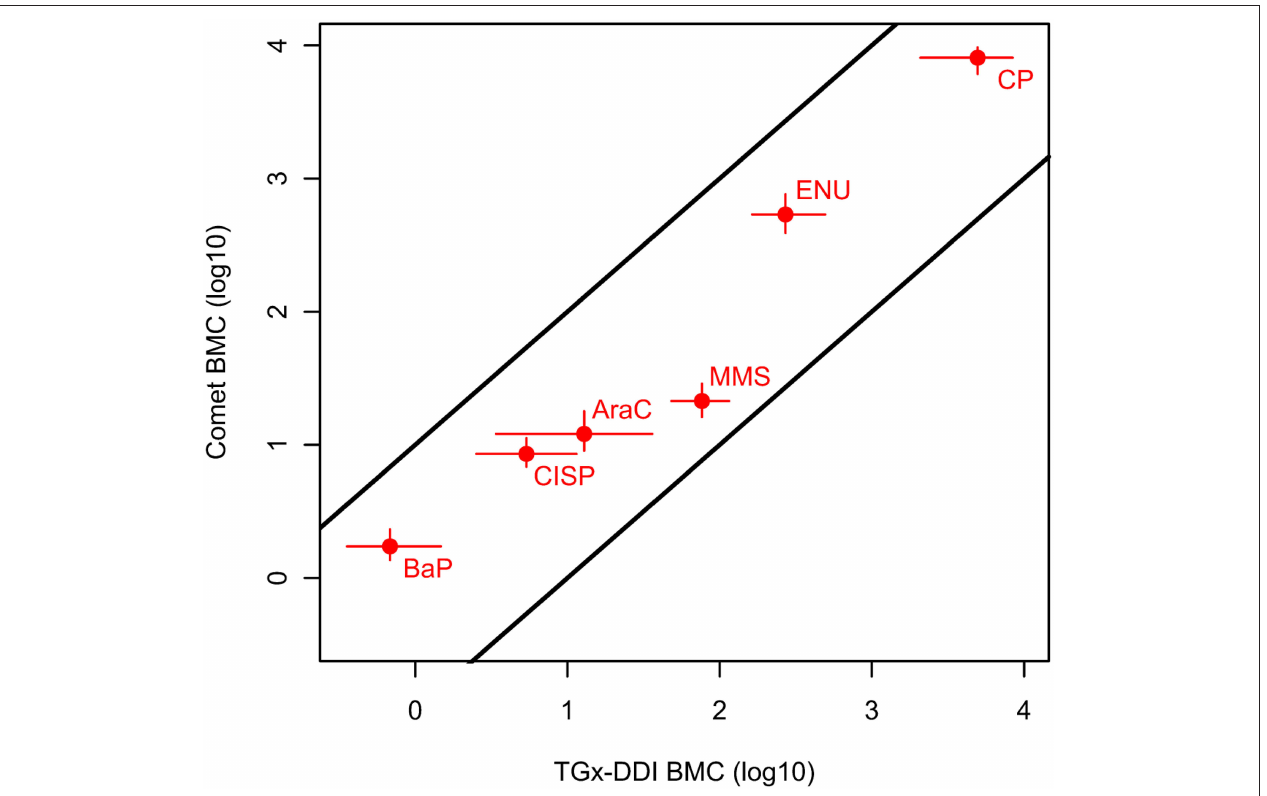
FIGURE 4 | Relationship between the BMCs of the CometChip ® data (BMC CC ) and the TGx-DDI biomarker genes (BMC TGx ) for the test chemicals that yielded positive hazard calls in both tests and could be modeled. Specifically, the BMC CC with a BMR of 1SD with two-sided 95% CIs are shown for the CometChip ® vs. median bootstrap BMC TGX (BMR of 1SD) with two-sided 95% CIs for the TGx-DDI biomarker classification endpoint. The BMCs for the agents that were classified as DDI from both approaches were within 10-fold. The two parallel black lines with intercepts of 1 and − 1 on the double log10 scale represent a 10-fold deviation from the 1:1